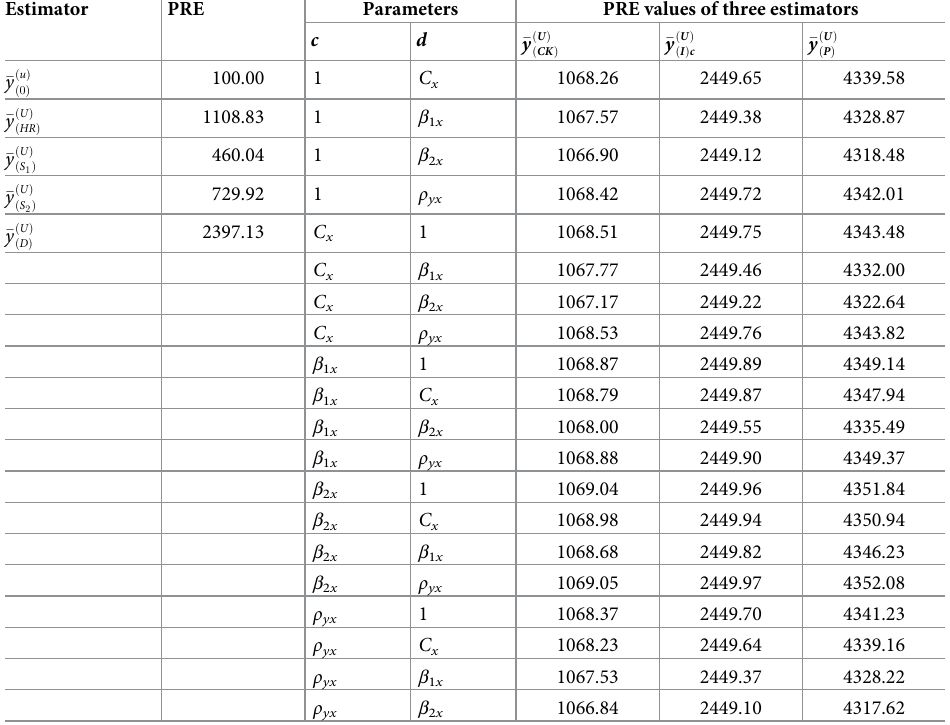
Table 3. Results of different estimators for Population 3.